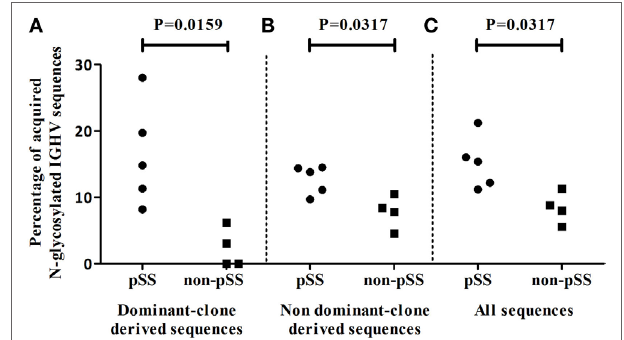
FigUre 5 | Incidence of ac-Nglycs in IGHV sequences in the salivary parotid gland biopsies. (a) The percentage of dominant clone-derived IGHV sequences containing at least one ac-Nglycs are shown per patient. (B) The percentage of glycosylated non-dominant clone-derived sequences per patient and (c) the percentage glycosylated sequences from all obtained IGHV (including dominant and non-dominant clone-derived IGHV sequences) sequences are depicted per